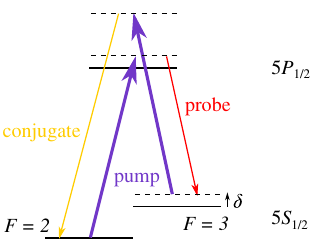
FIG. 2. Nondegenerate four-wave-mixing scheme on the D 1 line of 85 Rb. A single pump field creates correlations between the probe and conjugate fields, whose frequencies are separated by roughly twice the ground-state hyperfine splitting.